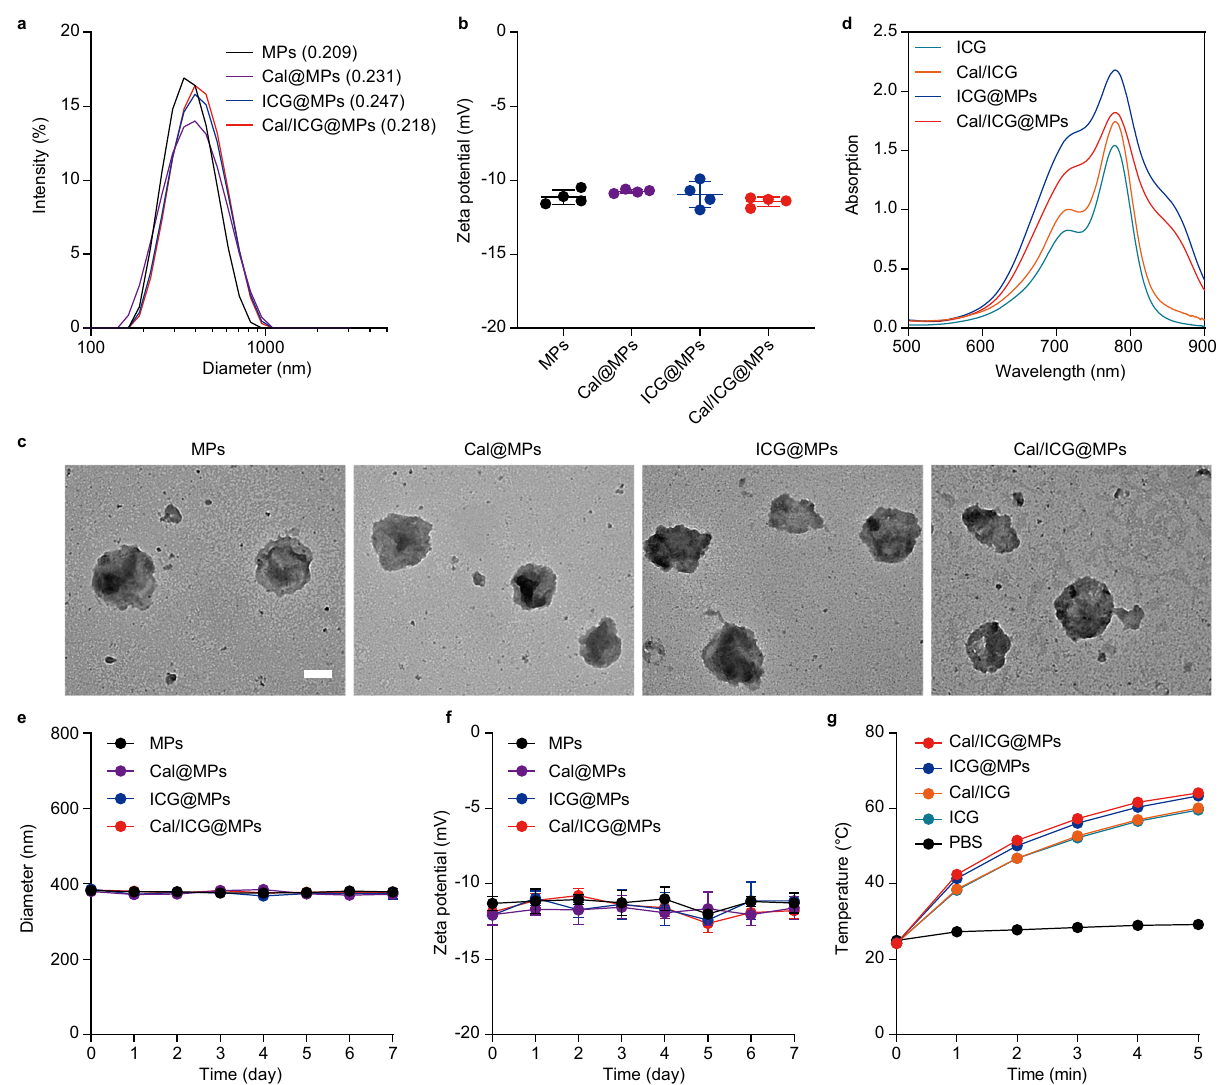
Fig. 2 Characterization of Cal/ICG@MPs. a Hydrodynamic diameter of MPs, Cal@MPs, ICG@MPs, and Cal/ICG@MPs by DLS analysis. Polydispersity index values are indicated in the brackets. b Zeta potentials of MPs, Cal@MPs, ICG@MPs, and Cal/ICG@MPs by DLS analysis. Data are presented as means± s.d. ( n = 4 independent samples). c Morphology of MPs, Cal@MPs, ICG@MPs, and Cal/ICG@MPs by TEM. Scale bar: 200nm. d UV-vis spectrum spectra of ICG, Cal/ICG, ICG@MPs, and Cal/ICG@MPs. e , f Diameters ( e ) and zeta potentials ( f ) of MPs, Cal@MPs, ICG@MPs, and Cal/ICG@MPs after incubation in PBS containing 10% FBS for different time intervals. Data are presented as means± s.d. ( n = 4 independent samples). g Temperature curves